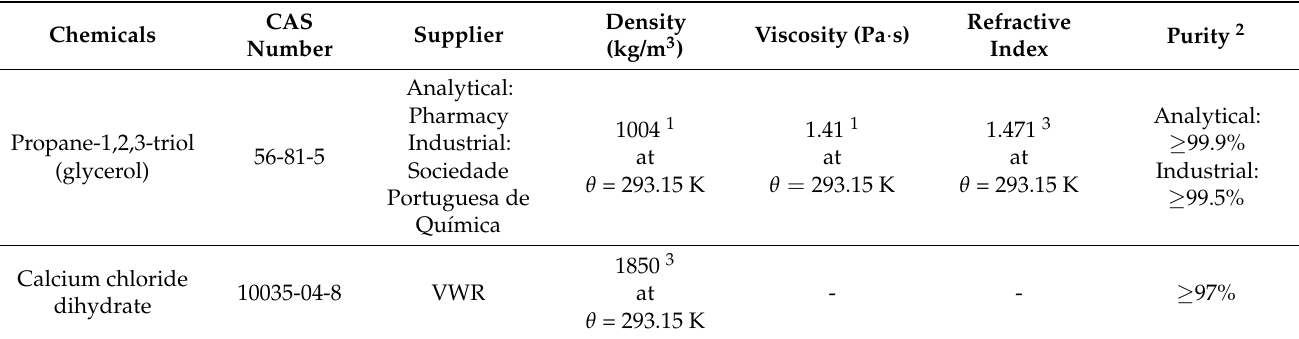
Table 2. Information for used chemicals in this